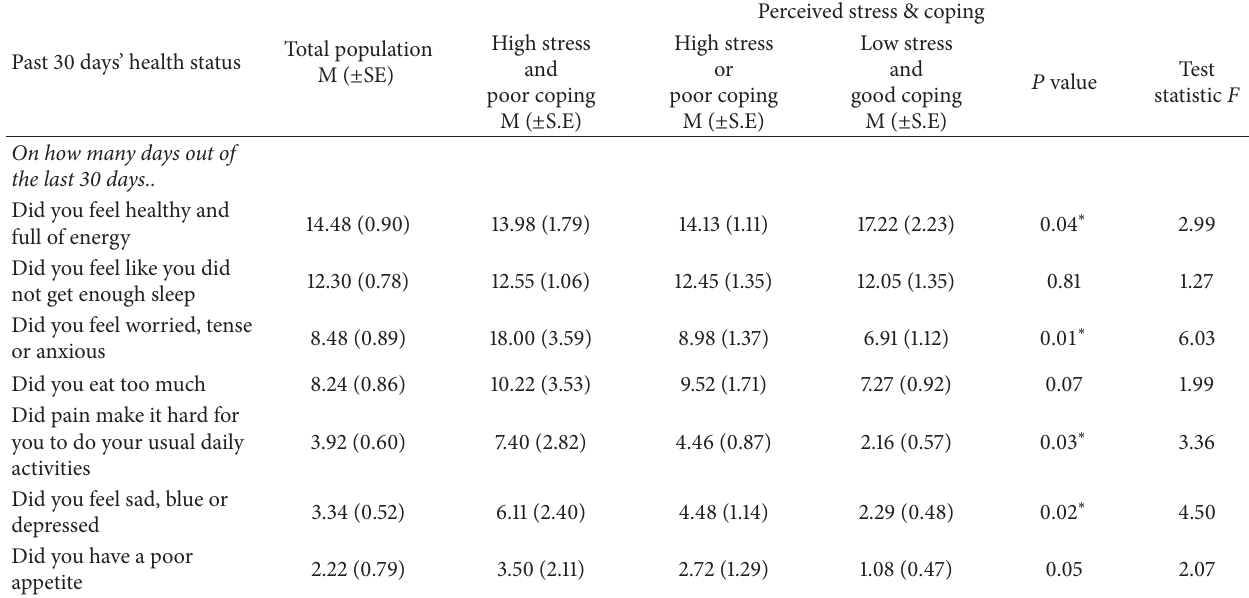
Table 3: Health status in the past month by level of stress and adequacy of